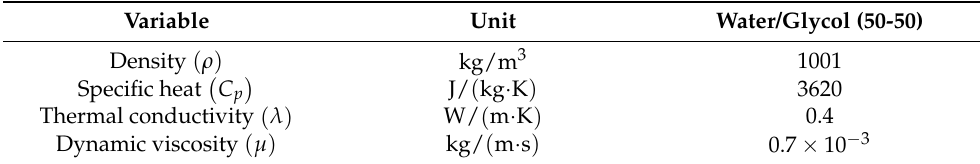
Table 1. Thermo-physical properties of water/glycol as the working fluid.